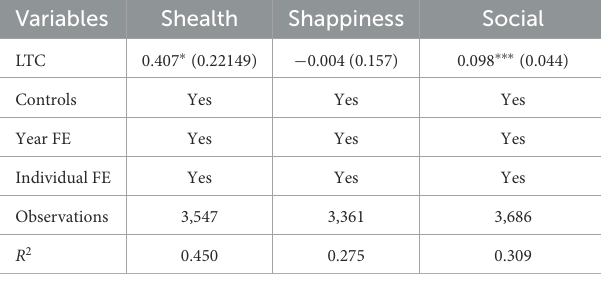
TABLE 11 The spillover effects of